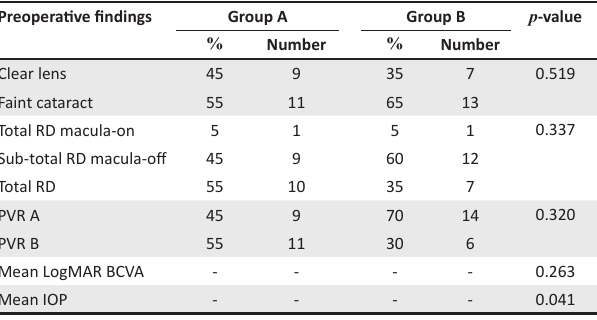
TABLE 1: Preoperative data for both groups.